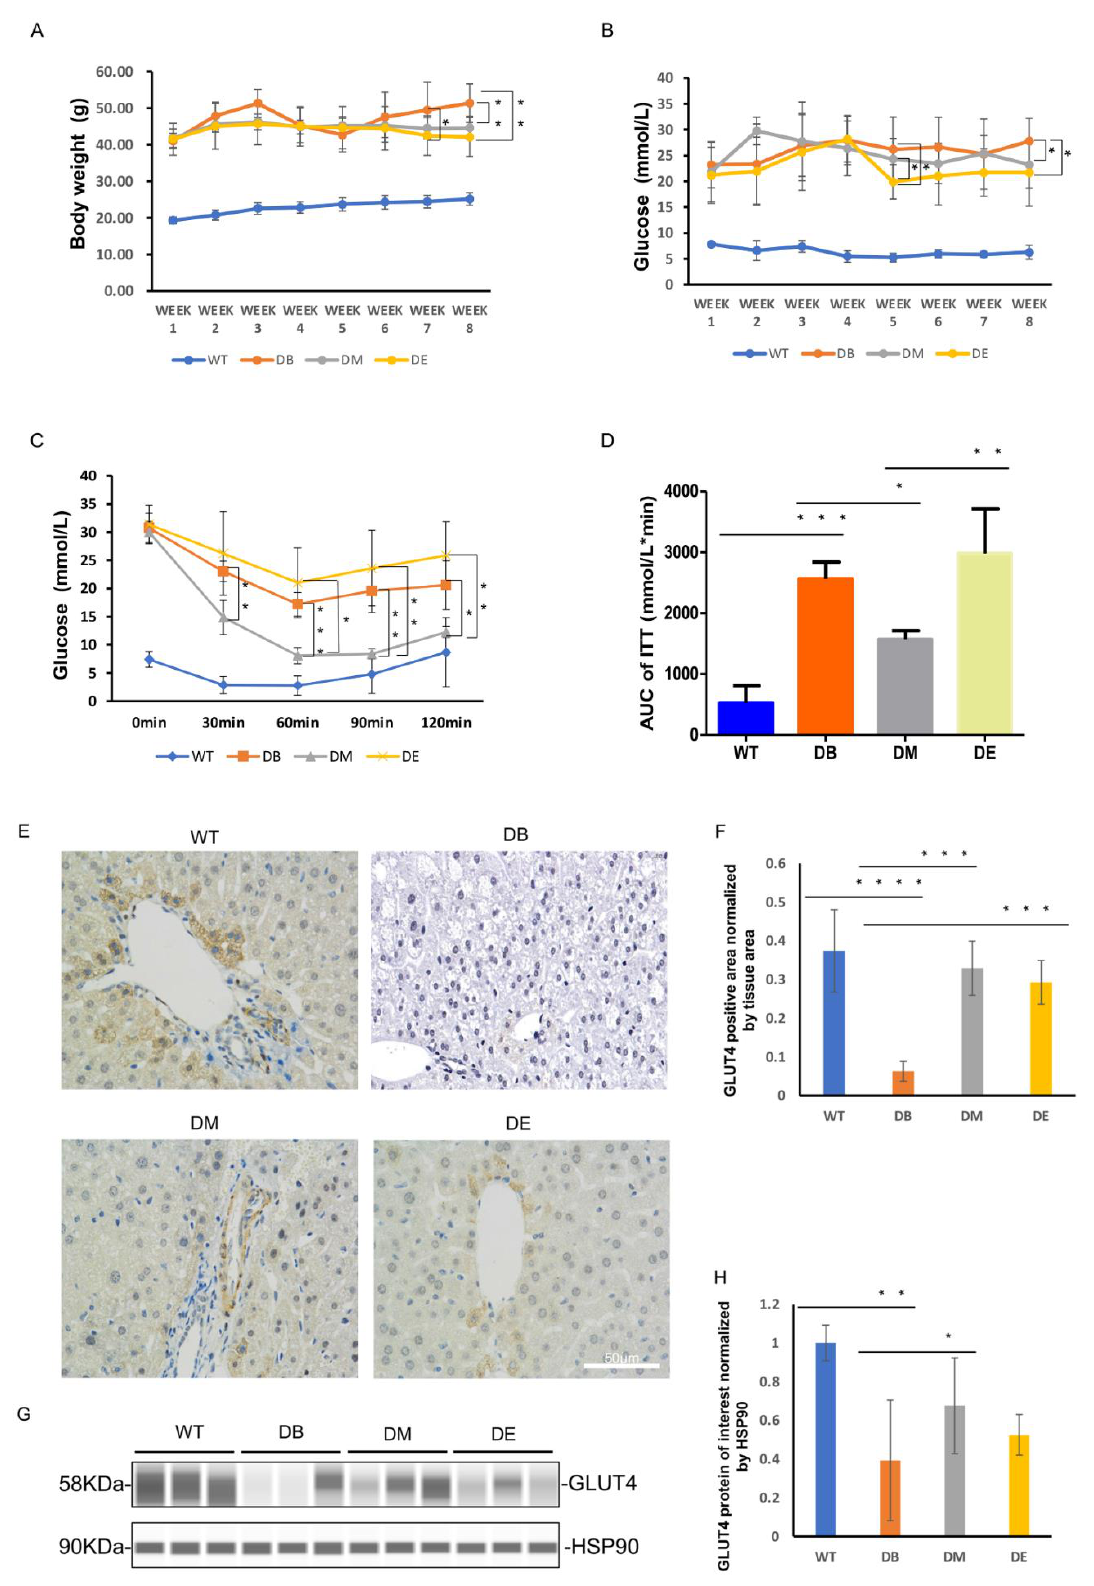
Figure 1. Chrono-exercise ameliorates blood glucose, and morning exercise improves insulin sensitivity in diabetic mice. ( A ) Body weight in WT, DB, DM, and DE mice. * p < 0.05 and ** p < 0.01, n = 8 – 12. ( B ) Changes in fasting blood glucose during the test. * p < 0.05, n = 8 – 10. ( C ) Blood glucose levels in the ITT test of groups WT, DB, DM, and DE mice after running. * p < 0.05, ** p < 0.01, and *** p < 0.001, n = 3 – 4. ( D ) Area under the curve of the ITT graph of ( C ). * p < 0.05, ** p < 0.01, and *** p < 0.001, n = 4. ( E ) GLUT4 was compared between different groups by GLUT4 antibody staining, n = 3. ( F ) Statistical evaluation of GLUT4 staining of ( E ), *** p < 0.001 and **** p < 0.0001. ( G ) Wes TM of GLUT4 expression in liver from groups WT, DB, DM, and DE mice. ( H ) Statistical evaluation of GLUT4 expression in the liver. * p < 0.05 and ** p < 0.01, n = 3. Exercise Downregulates Serum T-CHO in Diabetic Mice We found that both morning (DM) and night (DE) exercise significantly decreased the blood glucose levels. We wondered whether chrono-exercise also differentially af- fected the serum lipid levels. The serum lipid, T-CHO, and TG levels were assessed using Nanjing Jiancheng kits. We found that the T-CHO level of the DB group was significantly increased compared with that of the WT group ( p < 0.001; Figure 2A). The T-CHO levels of both the DM ( p < 0.001) and DE groups ( p < 0.01) were significantly decreased compared to that of the DB group (Figure 2A). Although the TG level of the DB group was signifi- cantly higher than that of the WT group ( p < 0.01), there was no difference between the DM and DE groups compared to the DB group (Figure 2B). We also applied HE staining to observe the liver structure and fat cavitation in dia- betic mice. Large amounts of fat infiltrate were observed in the DB, and the liver structure was severely damaged (Figure 2C). Morning and night exercise ameliorated fat infiltra- tion and serious structural damage, and the effect of night exercise was better than that of morning exercise (Figure 2C).